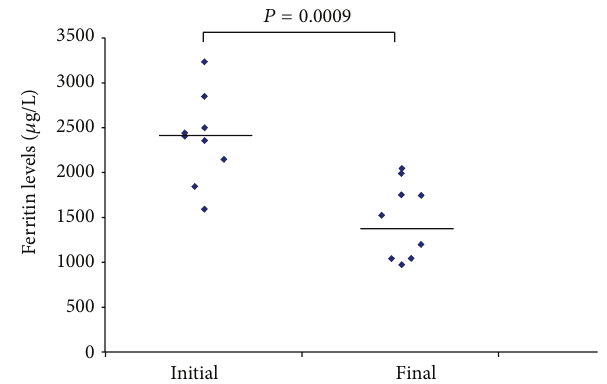
Figure 1: Serum ferritin concentrations during treatment with oral solution of deferiprone (Ferriprox 100mg/mL) in nine children with transfusion dependent